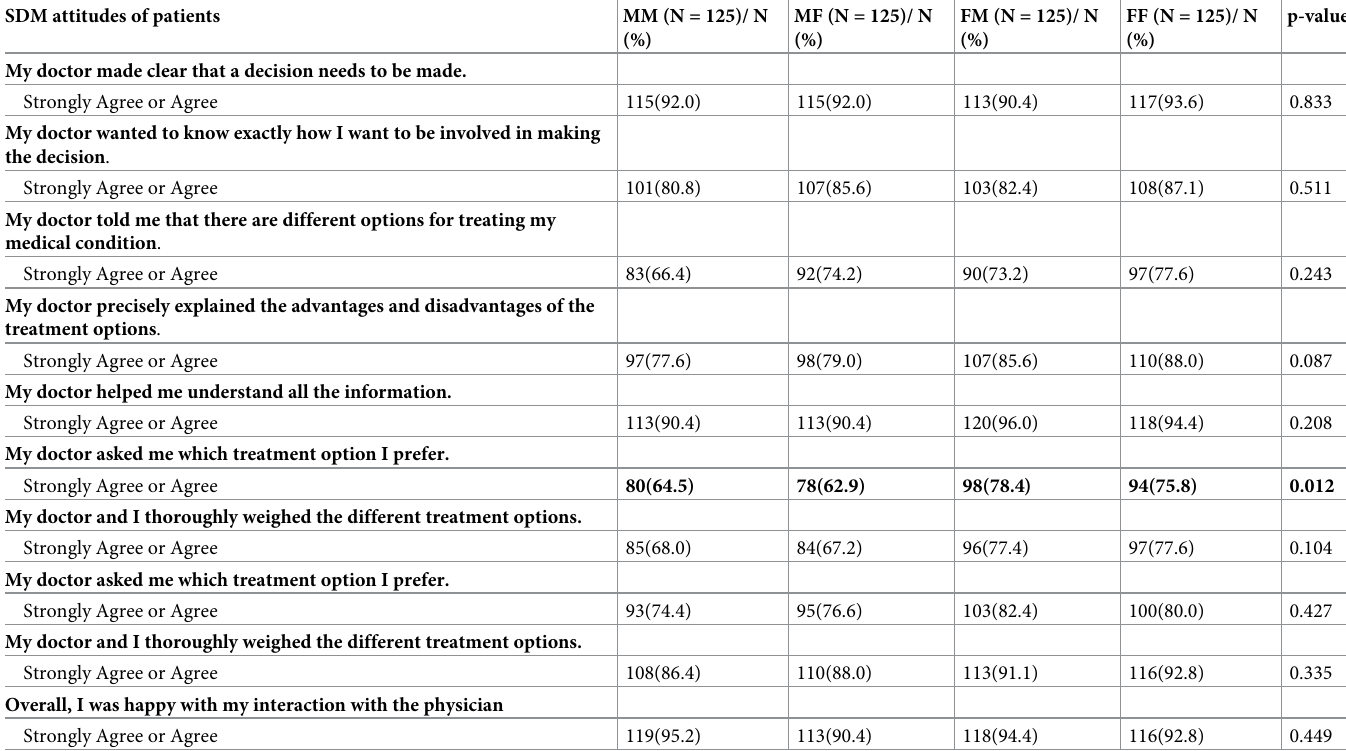
Table 3. Associations of physician-patient gender and the perspective of patients on their opportunity to engage with SDM. SDM attitudes of